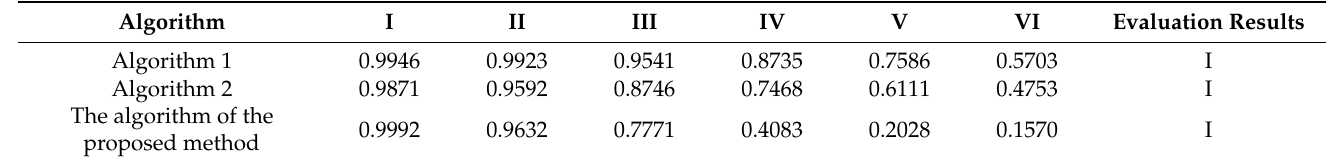
Table 12. Evaluation results of different algorithms in the polished rice